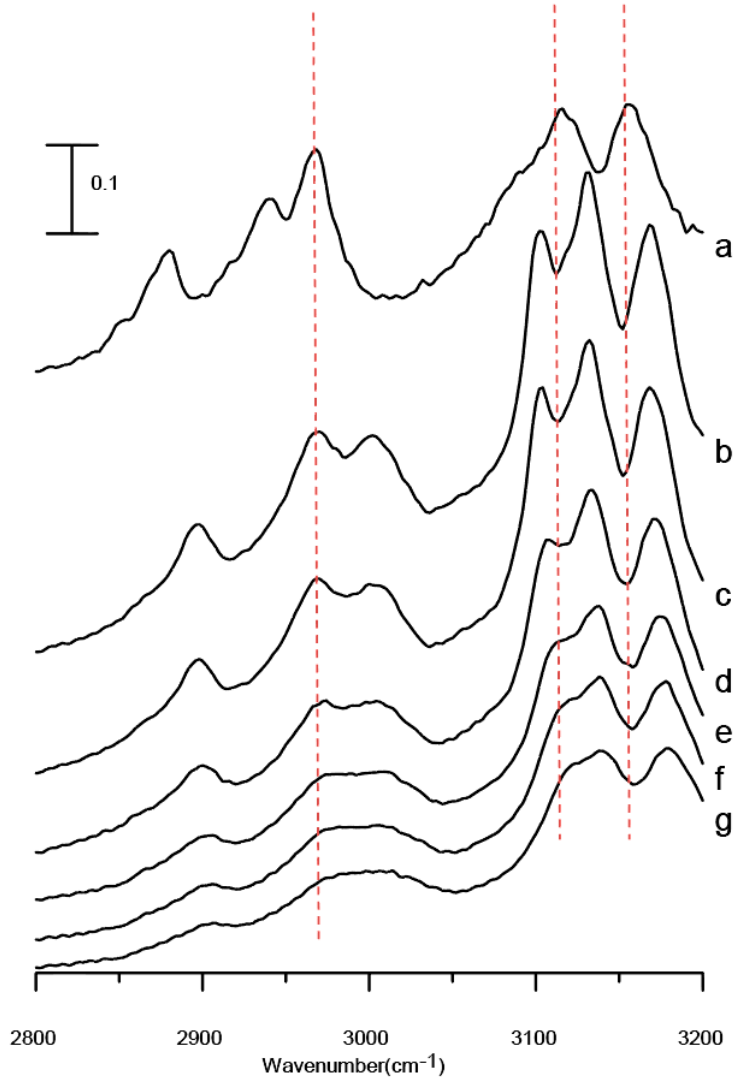
Figure 3. IR spectra of the [BMIM][TFS]/Al 2 O 3 mixture obtained under ambient pressure (curve a) and at 0.4 (curve b), 0.7 (curve c), 1.1 (curve d), 1.5 (curve e), 1.8 (curve f), and 2.5 GPa (curve g). Relative intensities of the IR bands are given in increments of 0.1; the scale bar is displayed in the upper left corner of the figure.